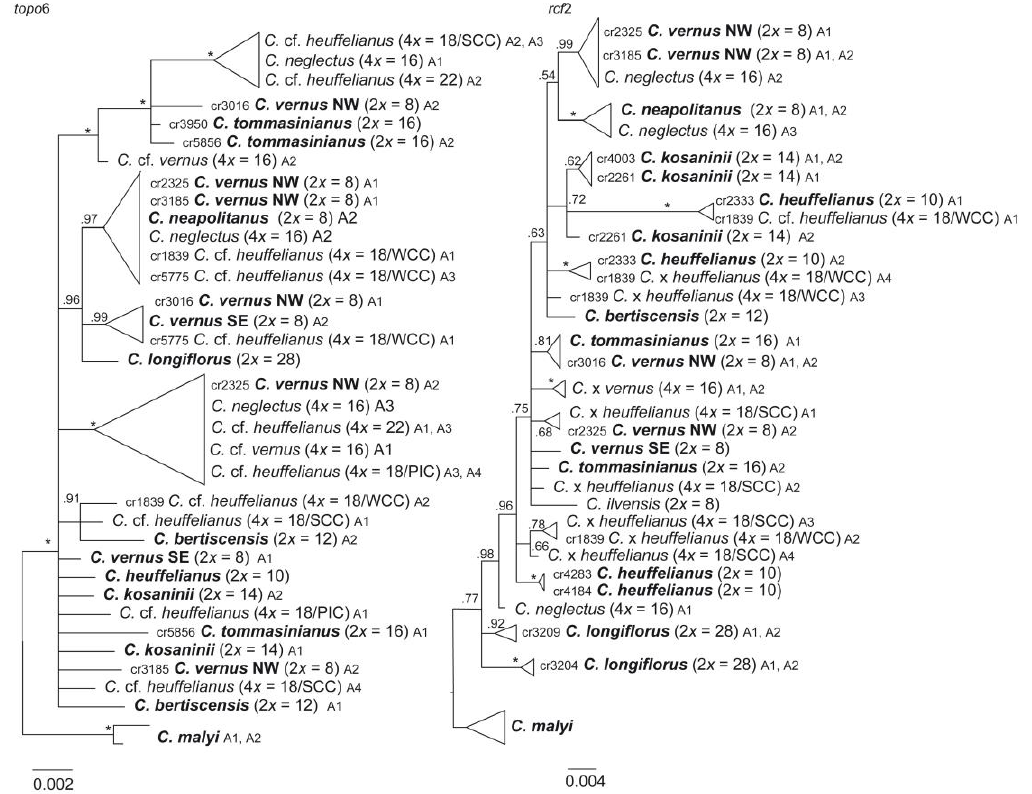
Figure 5. Phylogenetic trees obtained through Bayesian phylogenetic inference based on haplotype sequences of nuclear single-copy genes in Crocus ser. Verni . Numbers along branches indicate BI posterior probabilities (pp). Support values of 1.0 are indicated by asterisks. Allelic differences (A1– A4) in these markers were used to track the bi-parental contributions of diploids to allotetraploids. If more than one individual per species or cytotype was included, their DNA identifier (cr number) is provided. For detailed information, see Supplementary Figures S5 and S6.